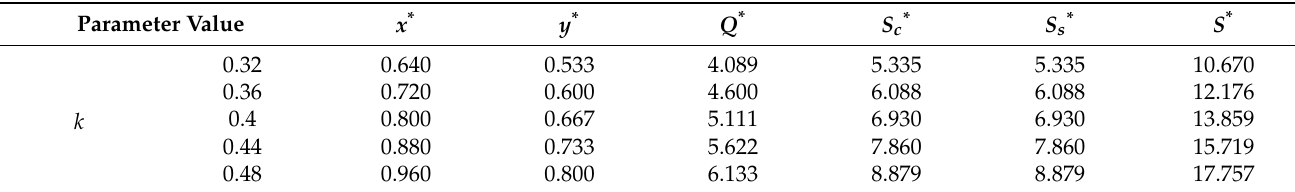
Table 7. Effect of Coefficient k on equilibrium